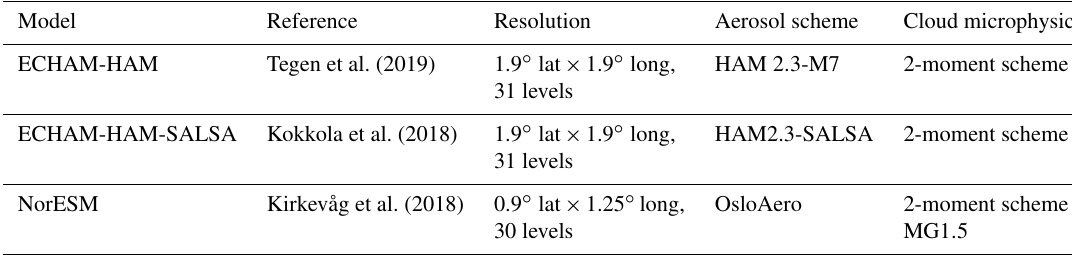
Table 2. Summary of the models used in the